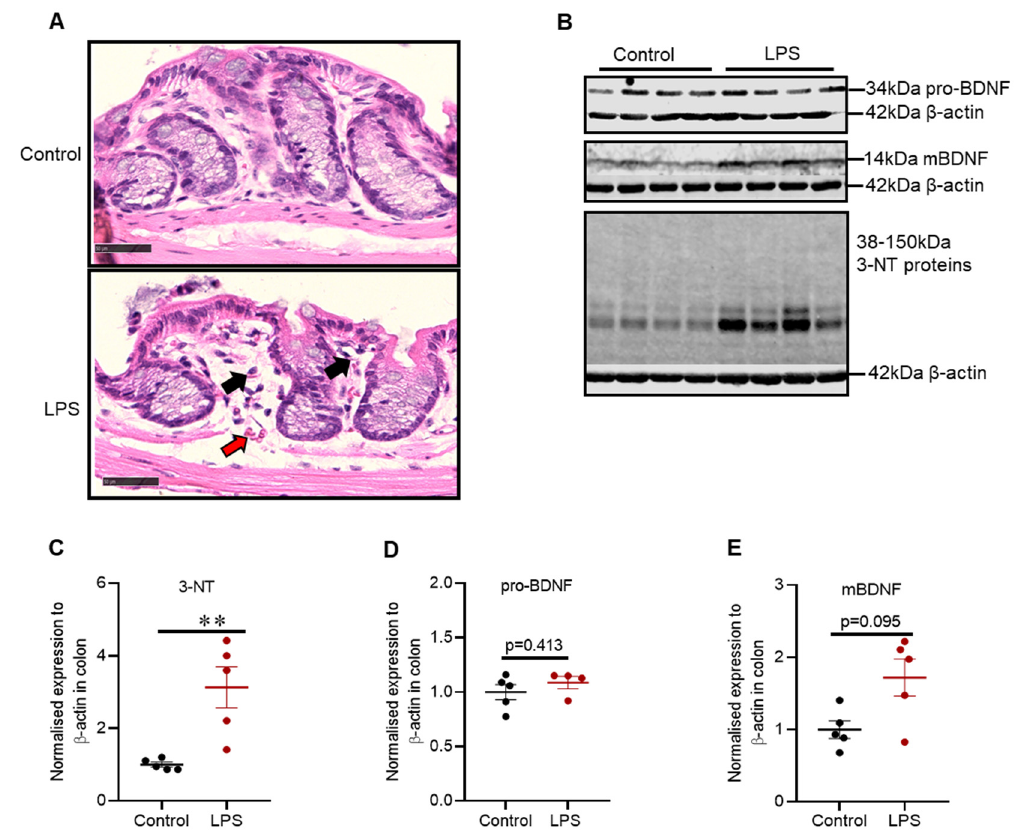
Figure 7. Intrastriatal administration of LPS induced mild inflammatory changes and alteration in oxidative stress markers in the distal colon of C57BL/6 mice. ( A ) Light microscopy of mouse distal colon stained with Hematoxylin and Eosin, whereby control mice showed intact epithelium lining with distinct muscularis mucosa, and LPS treated mice showed intact epithelium lining with a slight increase in mucosal vasculature (red arrow) and lymphocytes (black arrow) (Scale bar = 50 µ m, microscopic magnification: X400). ( B ) Representative immunoblots for 3-NT, pro-BDNF and mBDNF proteins. ( C ) Densitometric analysis of 3-NT proteins. ( D ) Densitometric analysis of pro-BDNF. ( E ) Densitometric analysis of mBDNF. The results are presented as mean ± SEM (control n = 5; LPS n = 4–5). Statistical analysis was performed with a Mann–Whitney test, p < 0.01(**). Table 1. Summary of the proteins examined by Western blot. Downwards ( ↓ ) and upwards ( ↑ ) arrows indicate the direction of “significance”, left-right arrow ( ↔ ) refers to “no significance”, and dash (-) refers to “not assessed”.